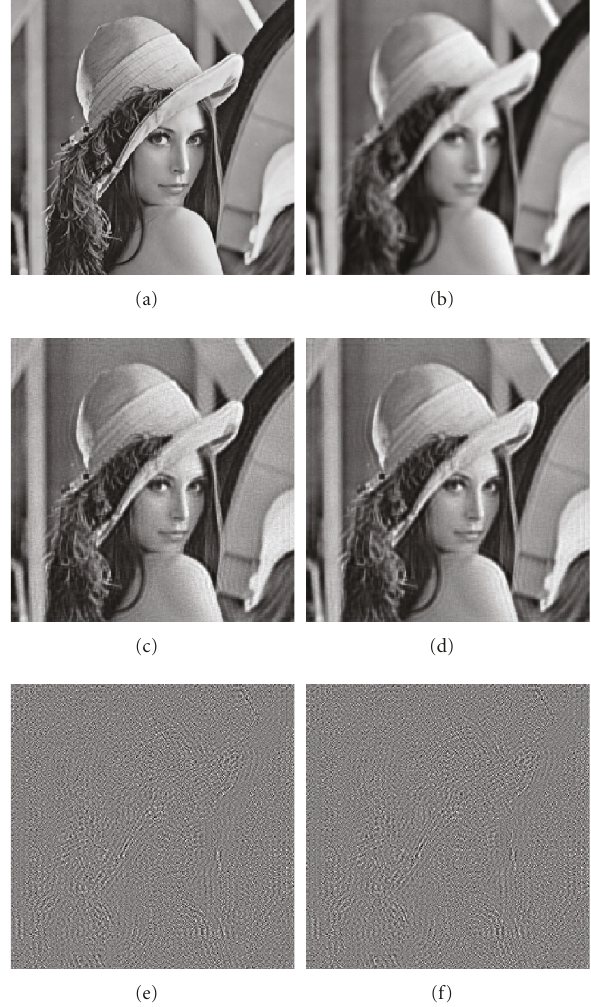
Figure 3: “Lenna” image (a) original image, (b) noisy and blurred image; PSF 5 × 5 Box-Car, BSNR = 32 dB, (c) restored image by MAPE corresponding to maximum SNR (79 iterations), (d) restored image by AAMAPE corresponding to maximum SNR (44 iterations), (e) residual corresponding (c), and (f) Residual corresponding